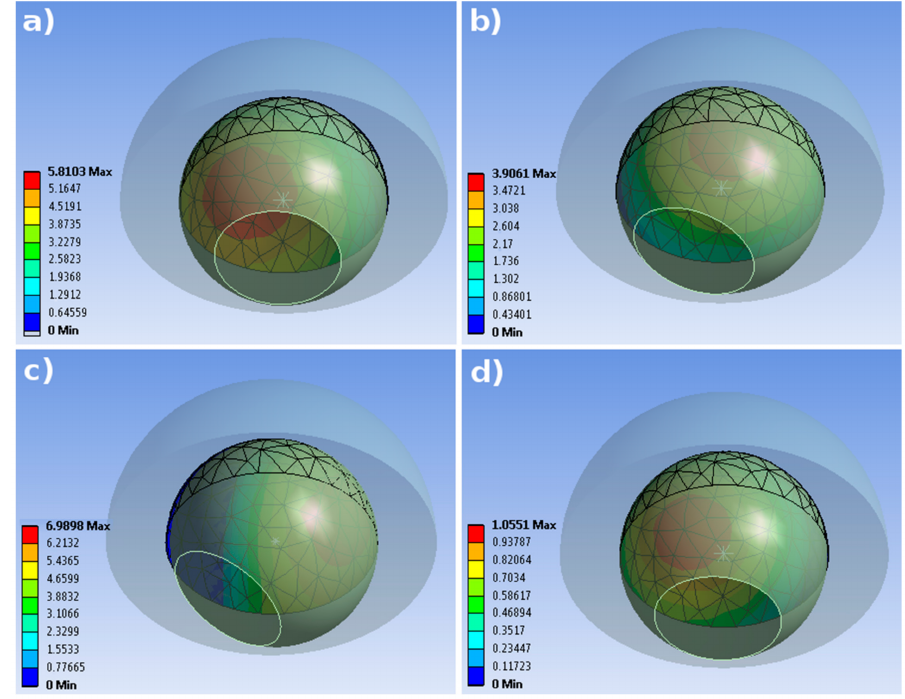
Figure 5. Pressure distribution on the internal surface of the acetabula cup. ( a ) NC case, dry condition; ( b ) NC case, wet condition; ( c ) CC case, dry condition; ( d ) CC case, wet